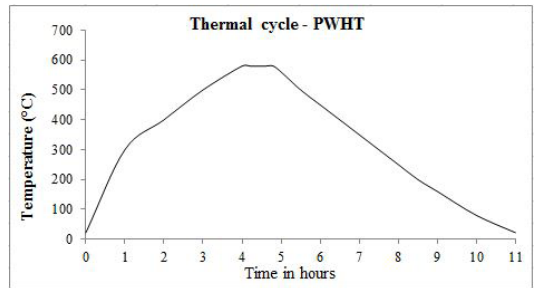
Figure 4. Thermal cycle for the treatment of Domex 700 MC steel.